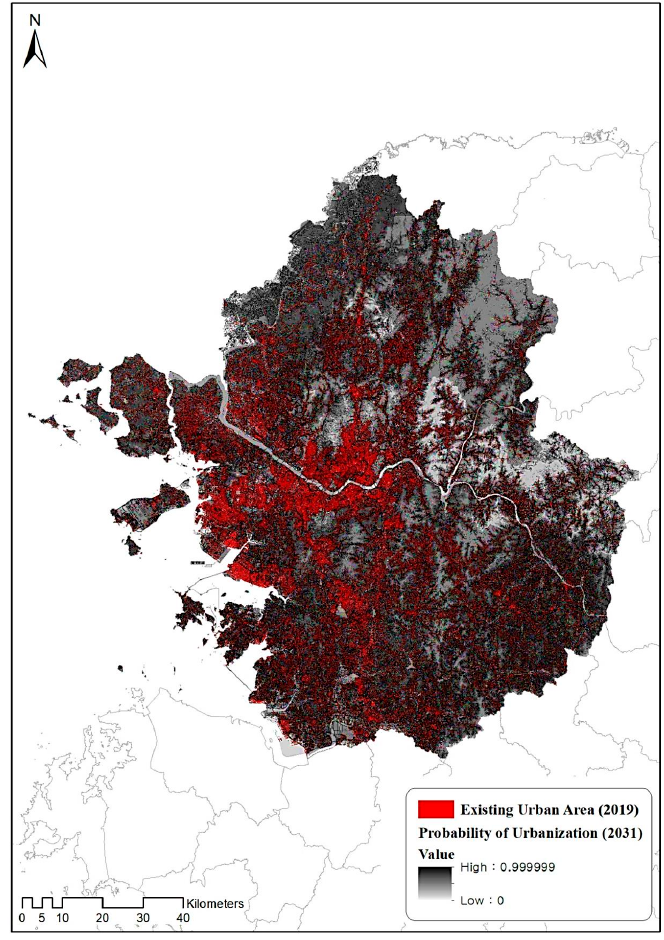
Figure 8. Prediction map of urban growth in SMA (2031).